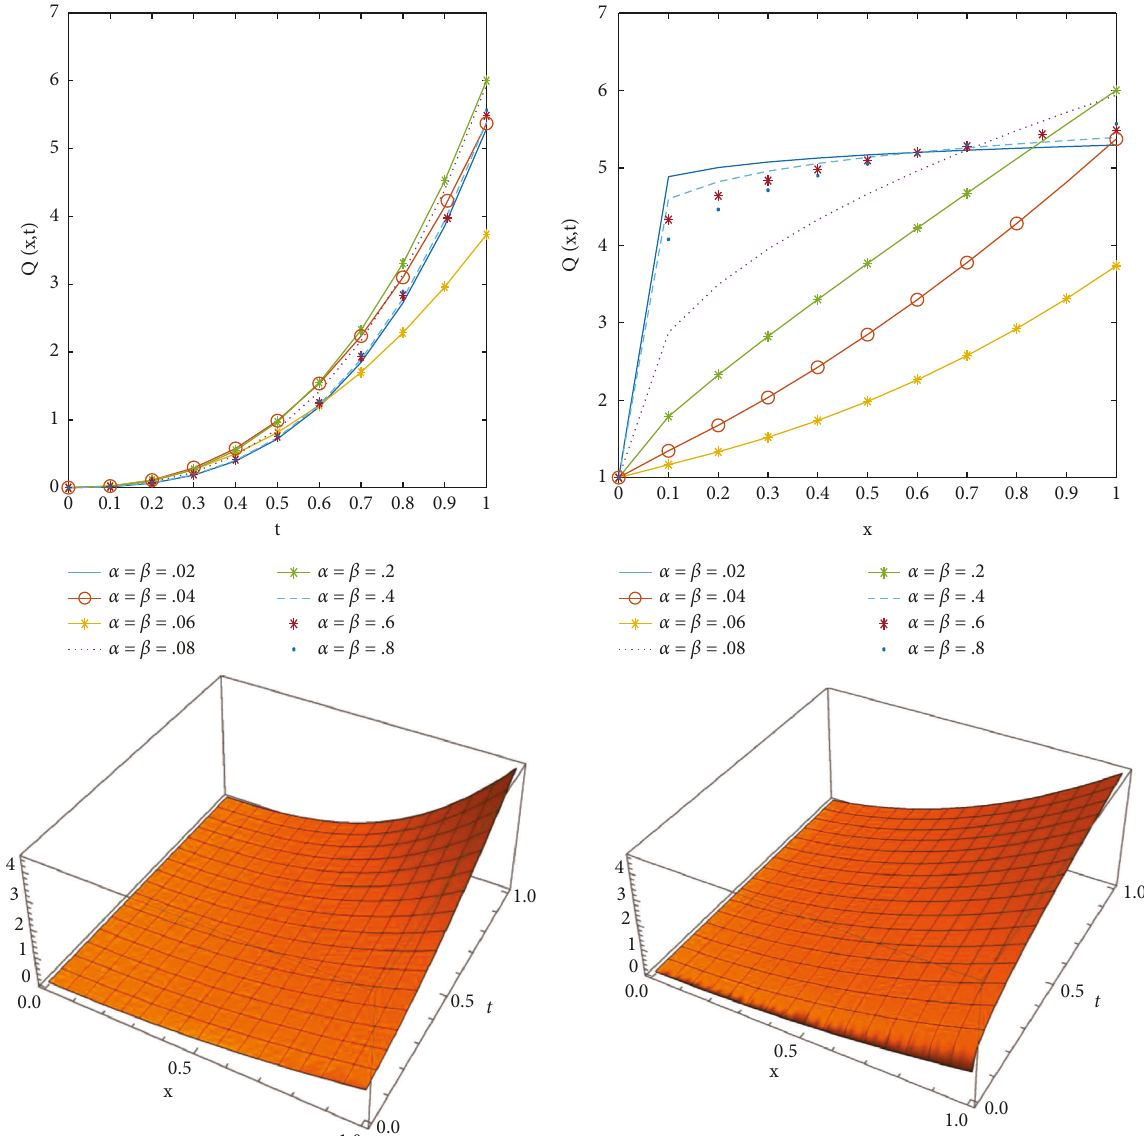
Figure 2: Comparison of the solution at various values of alpha and